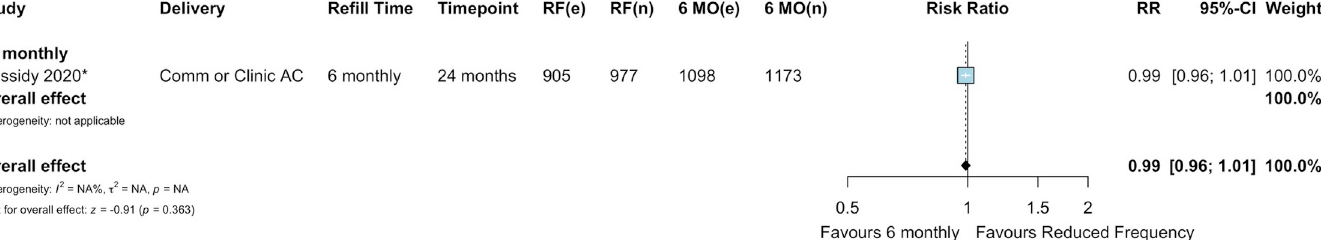
Fig 3. Retention in care: Reduced frequency versus 6-monthly clinical consultations. � Cluster-adjusted RR. 6 MO, 6-monthly; AC, adherence club; Comm, community; e, number of events; n, number of participants; RF, reduced frequency; RR, risk ratio.